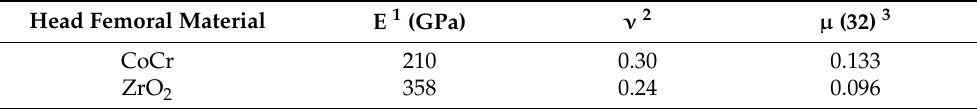
Table 3. Mechanical properties for the femoral head and equations of Hertz contact theory.